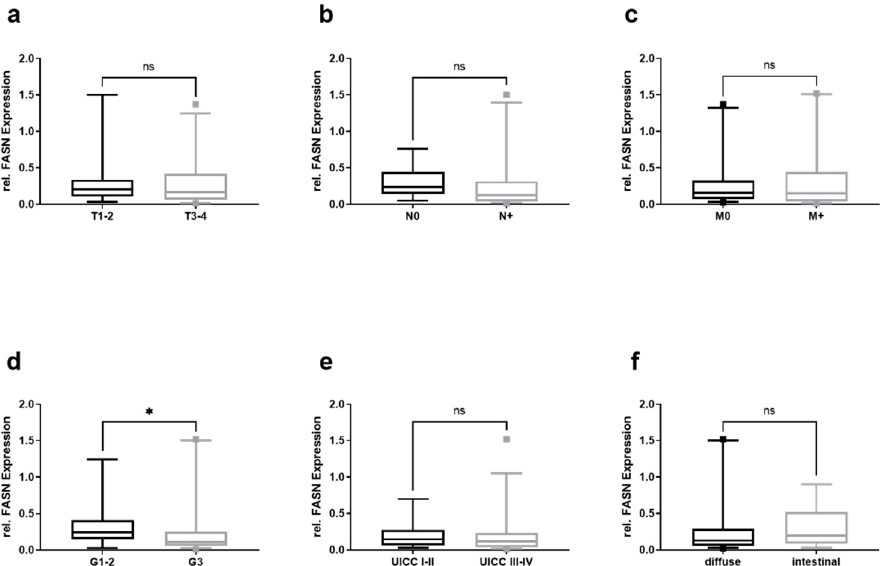
Figure 3. Relative FASN mRNA levels in EVs from GC patients and their clinico-pathological stratification. Relative mRNA levels of FASN in ( a ) T1–2 and T3–4 gastric cancers, ( b ) nodal negative (N0), and nodal positive (N+), ( c ) non-metastasized (M0) and metastasized (M+), ( d ) grade 1–2 (G1–2) and grade 3–4 (G3–4), ( e ) UICC-stage I–II and III–IV, and ( f ) according to Laur é n’s